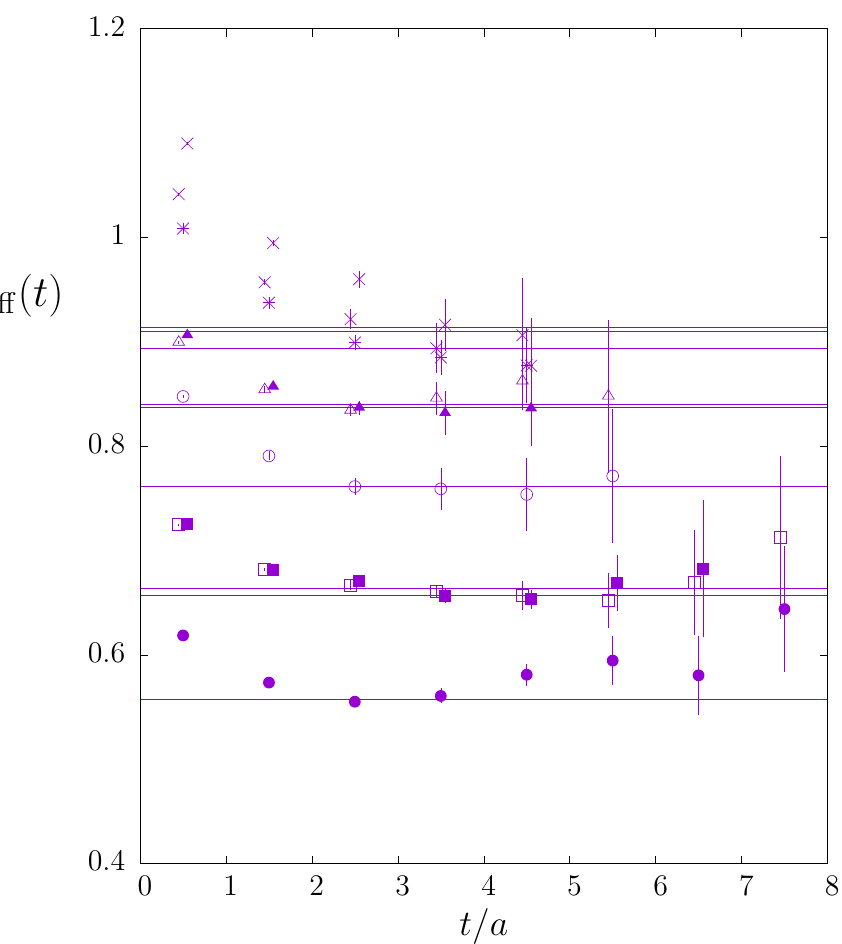
Figure 8 . Effective masses for the ground ( • ) and first excited ( ◦ ) J PC = 0 − + states. Also the ground and first excited J PC = 2 − + states: 2 of the 5 components from the E representation ( (cid:4) , N ) and the other 3 from the T 2 representation ( (cid:3) , M ). And the lightest three J PC = 1 − + states ( ?, × , + ), each triply degenerate. Some points shifted for clarity. Horizontal lines are our best mass estimates. On the 38 4 lattice at β = 6 . 50